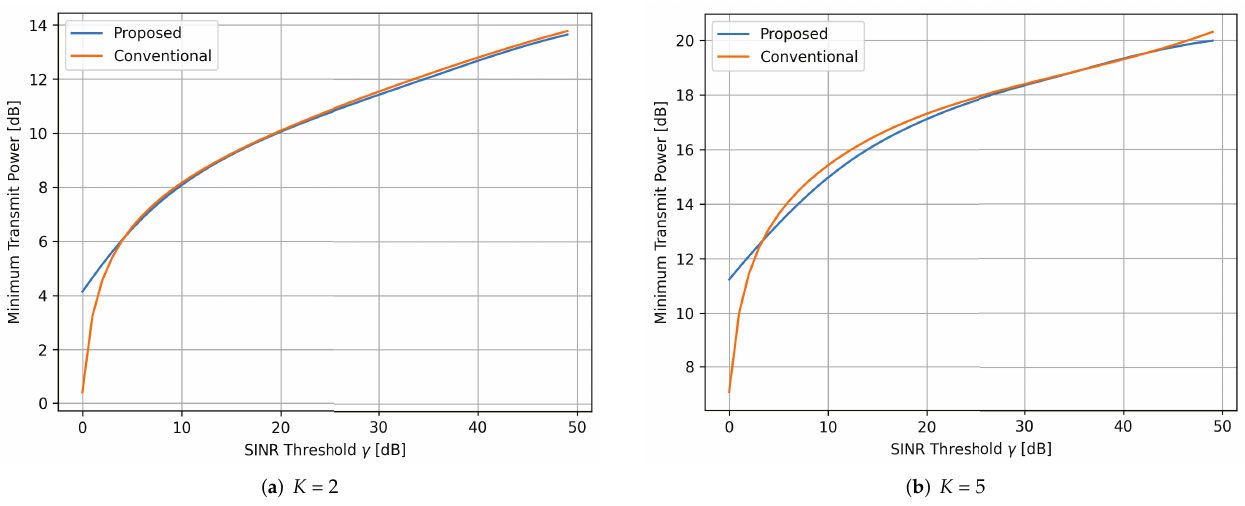
Figure 6. Minimum transmit power versus the SINR threshold for the downlink with v = 300